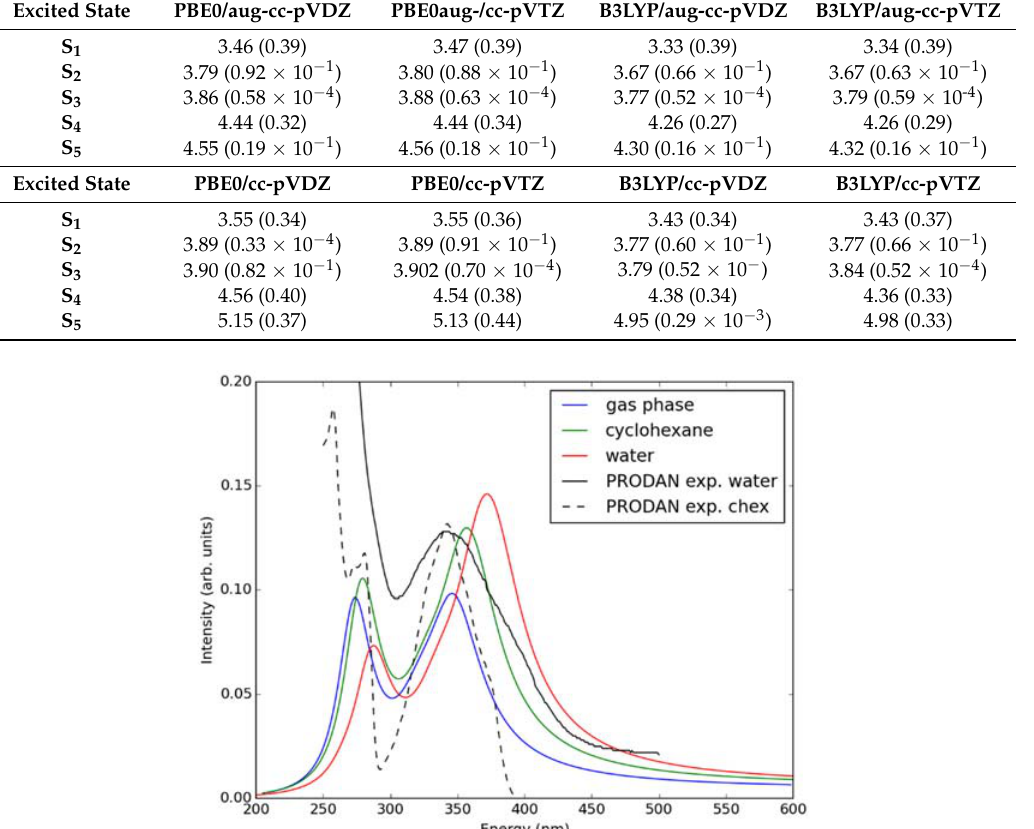
Table 3. Vertical excitation energies in eV (oscillator strengths are given in parentheses) of Laurdan in the cyclohexane environment modeled by implicit COSMO model calculated employing various TD-DFT functionals and basis sets.